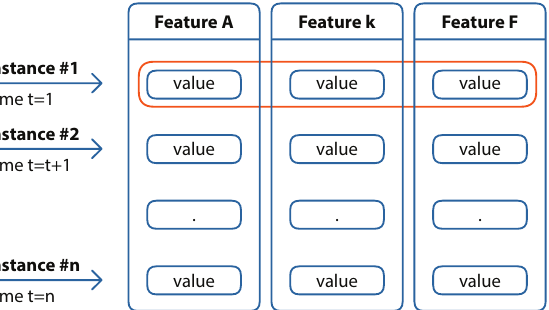
Figure 2. Online learning: The number of features is fixed; the number of instances is dynamic (i.e., increases over